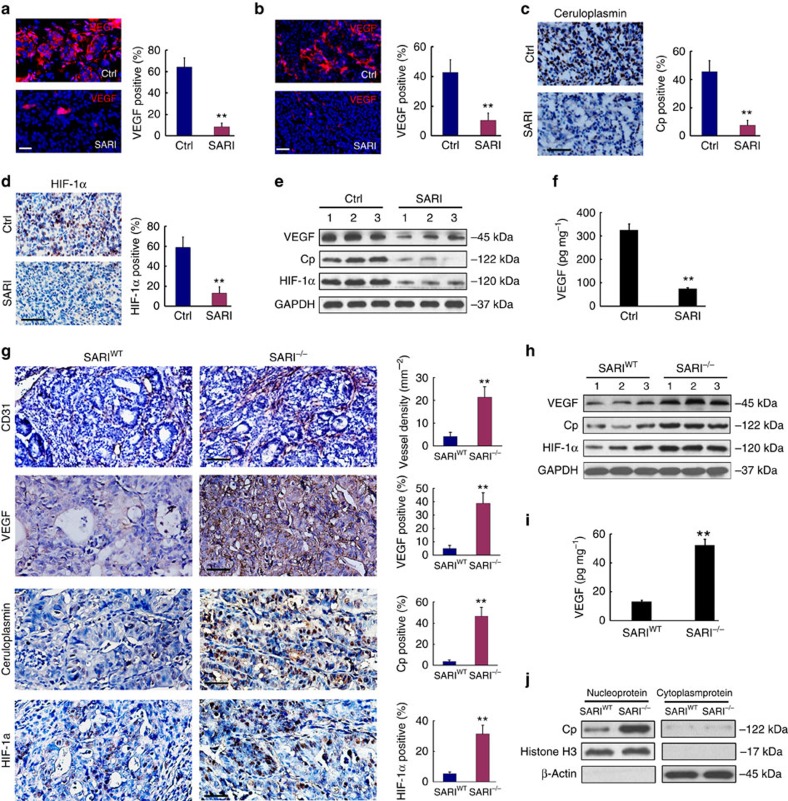
SARI inhibits expression of downstream targets in vivo.(a) Staining for VEGF (red) revealed less VEGF-positive cells in SARI than in controlSW480Matrigel plugs, Scale bar, 50 μm; VEGF-positive (%; VEGF positive per total cells; n=5; **P<0.01; Student's t-test). (b) Staining for VEGF (red) revealed less VEGF-positive cells in SARI than in control HCT116 tumours (d), Scale bar, 100 μm; VEGF positive (%;VEGF positive per total cells; n=5; **P<0.01; Student's t-test). (c) Staining for Cp revealed less Cp-positive cells in SARI than in control HCT116 tumours, Scale bar, 100 μm; Cp positive (%;Cp positive per total cells; n=5; **P<0.01; Student's t-test). (d) Staining for HIF-1α (red)-positive cells in SARI and control HCT116 tumours, Scale bar, 100 μm; HIF-1α positive (%; HIF-1α positive per total cells; n=5; **P<0.01; Student's t-test). (e) Immunoblots of VEGF, Cp and HIF-1a expression in SW480-control and SW480-SARI tumours. GAPDH was used as the loading control. (f) ELISA detection of VEGF expression in SW480-control and SW480-SARI tumours (n=3; **P<0.01; Student's t-test). (g) Staining for CD31, VEGF, Cp and HIF-1α in colonic tumours of AOM/DSS induction. Analysis of the number of microvessels, VEGF-positive cells, Cp-positive cells and HIF-1α-positive cells (n=4; **P<0.01; Student's t-test). Scale bar, 100 μm. (h) Immunoblots of VEGF, Cp and HIF-1α expression in colonic tumours of SARI−/− and SARIWT mice after AOM/DSS induction. GAPDH was used as the loading control. (i) ELISA detection of VEGF expression in colonic tumours of SARI−/− and SARIWT mice after AOM/DSS induction. (n=3; **P<0.01; Student's t-test) (j) Nuclear and cytoplasmic proteins were collected from the colonic tumours of SARI−/− and SARIWT mice after AOM/DSS induction. Western blotting was performed to detect Cp expression. Histone H3 was used as the nuclear loading control and β-actin as the cytoplasmic loading control.